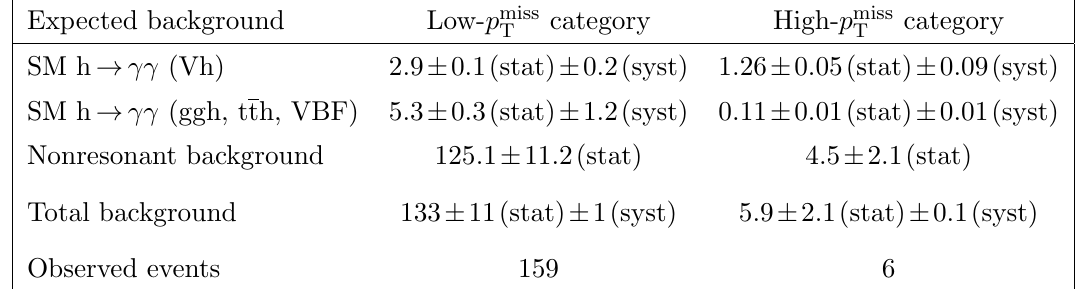
Table 5 . Expected background yields and observed numbers of events for the h ! (cid:13)(cid:13) channel in the m (cid:13)(cid:13) range of 122{128 GeV are shown for the low- and high- p miss